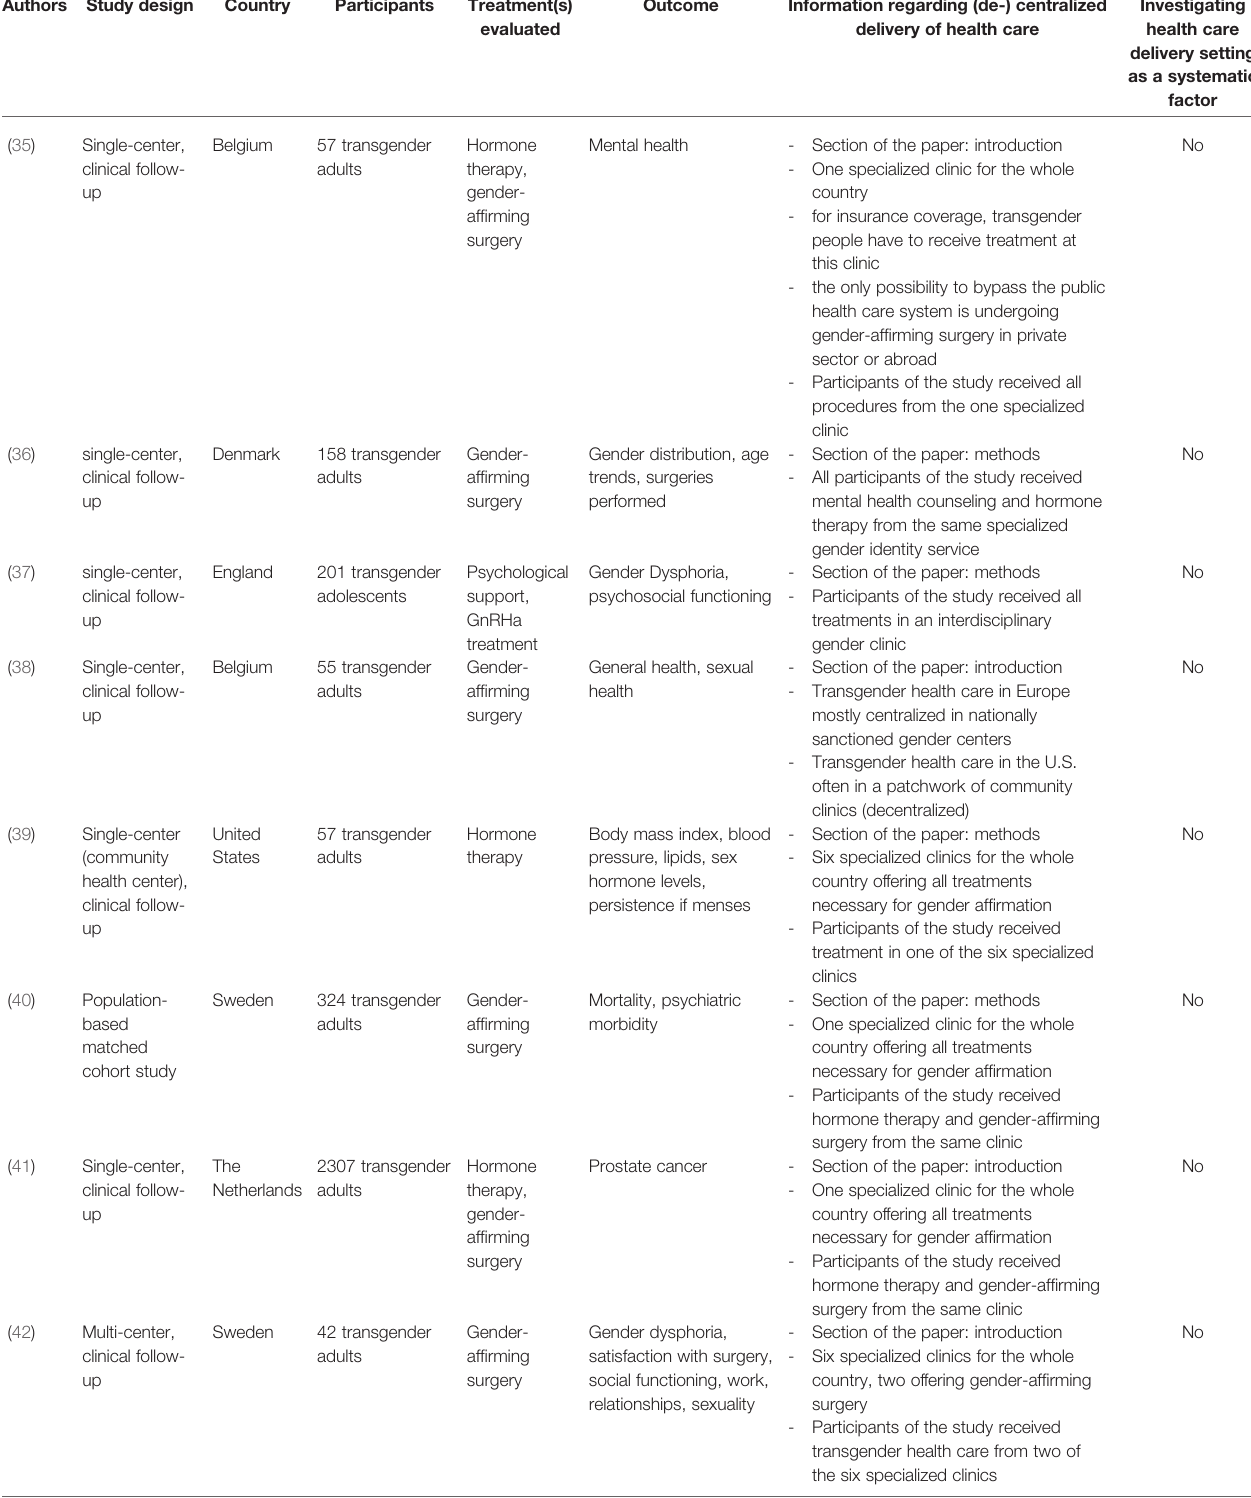
TABLE 1 | Studies included in the systematic